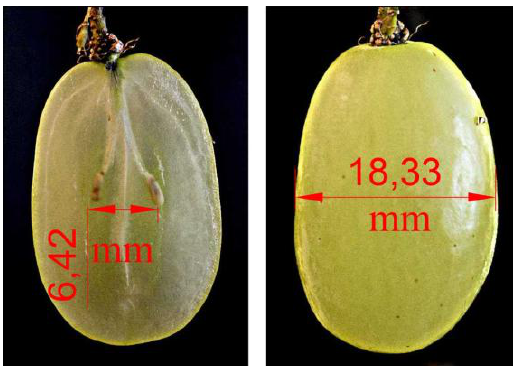
Figure 18. Section and frontal view of a acinus